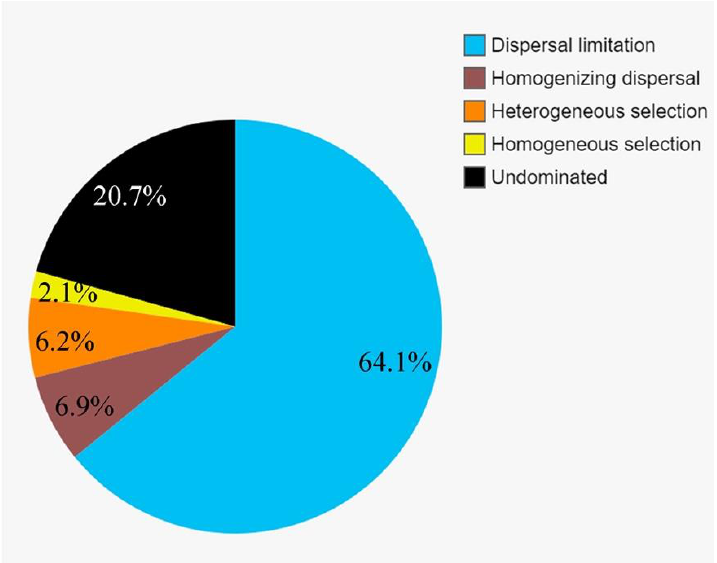
Figure 8. Partition of the community assembly process of the active protistan communities.